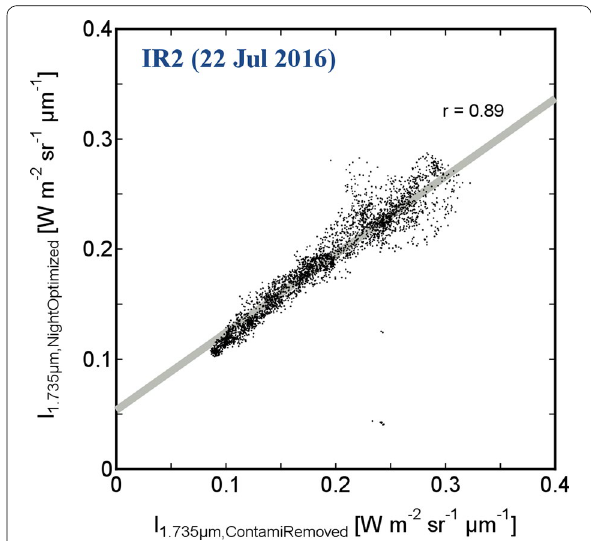
Fig. 12 Scatter plot comparing an image acquired at 1.735 μm after removal of contamination and an optimized night‑side image (sepa‑ rated by 1.5 h on July 22, 2016). The correlation coefficient is good ( r 0.89) with both types of data biased above true zero =